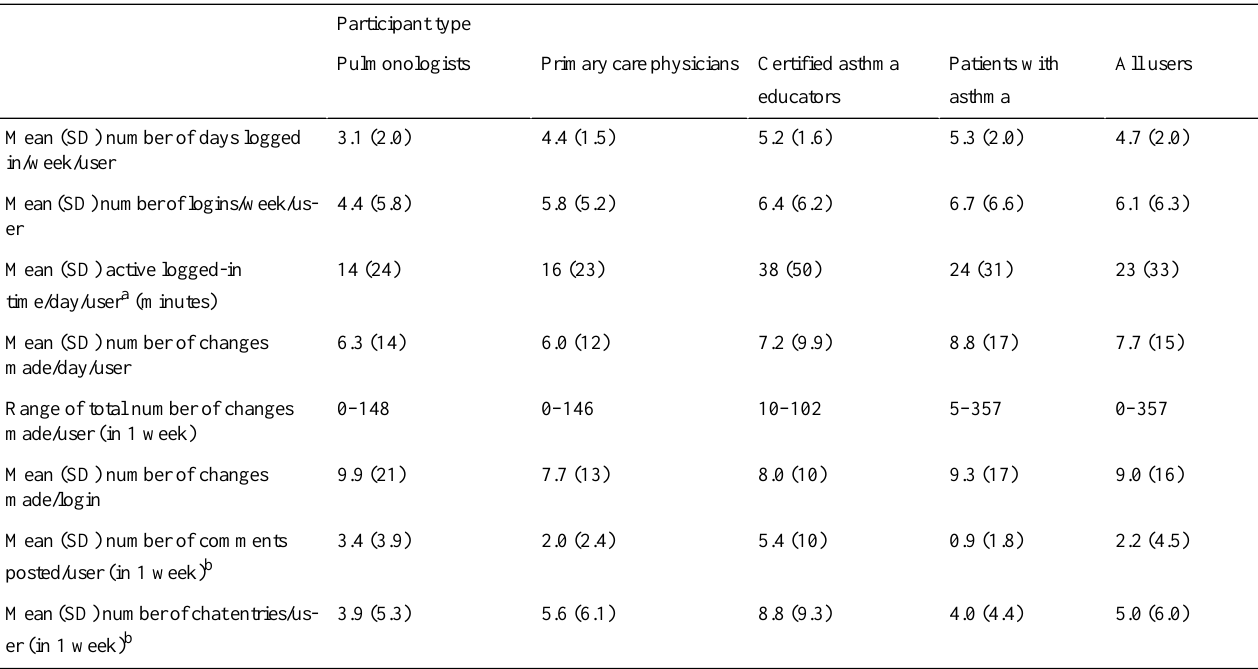
Table 2. System usage data